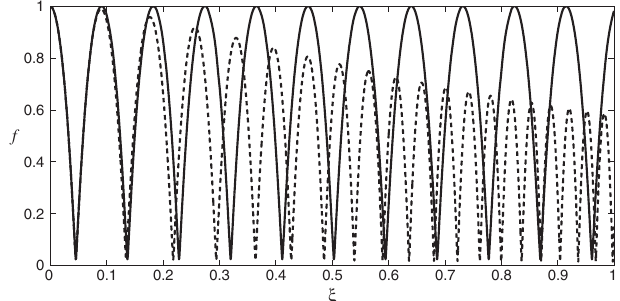
FIG. 1. Variation of the beamwidth parameter, f , with the Þ ,fortheramped dimensionlessdistanceofpropagation, ξ ¼ z= ð 2 R d density profile with B ¼ 2 (dashed) and the uniform density B ¼ 0 ¼ 10 9 K, n ¼ 4 × 10 19 cm − 3 , p ¼ 0 . 5 , r ¼ (solid) at T 0 e 0 0 F 20 μ m and ω ¼ 1 . 778 × 10 20 s − 1 . The laser propagation length at ξ ¼ 1 is equal to twice the Rayleigh